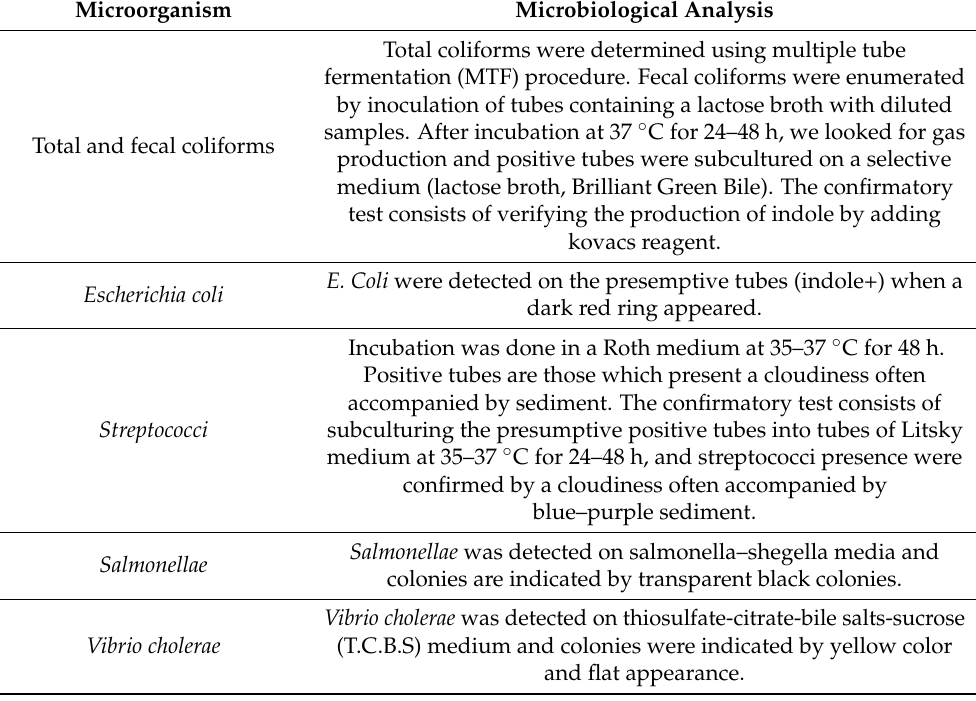
Table 2. Methods of microbiological